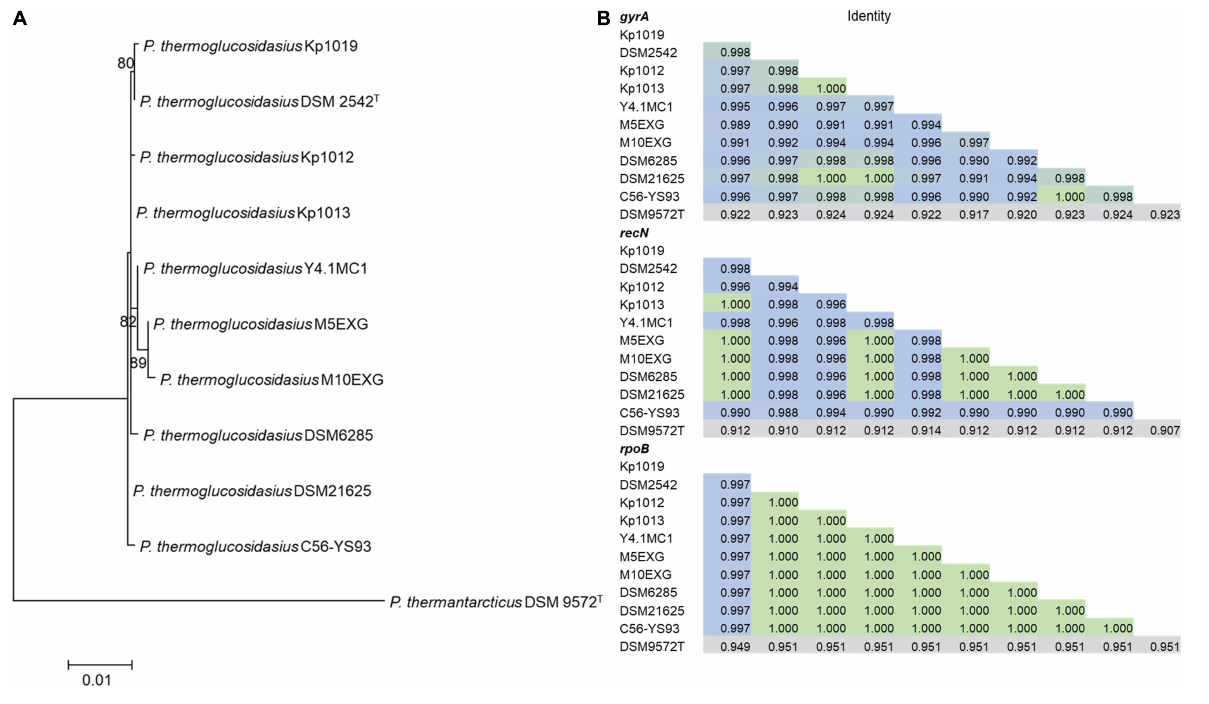
FIGURE 1 | Phylogenetic analysis of ten P. thermoglucosidasius strains included in this study with P. thermantarcticus DSM 9572 T used as outgroup. (A) Maximum likelihood tree of concatenated nucleotide alignment (1,851 characters) of PCR amplified gyrA, recN and rpoB partial sequences. The ML tree was inferred using IQ-TREE (Schmidt et al., 2014), (B) Identity matrices of the individual alignments of gyrA, recN and rpoB.